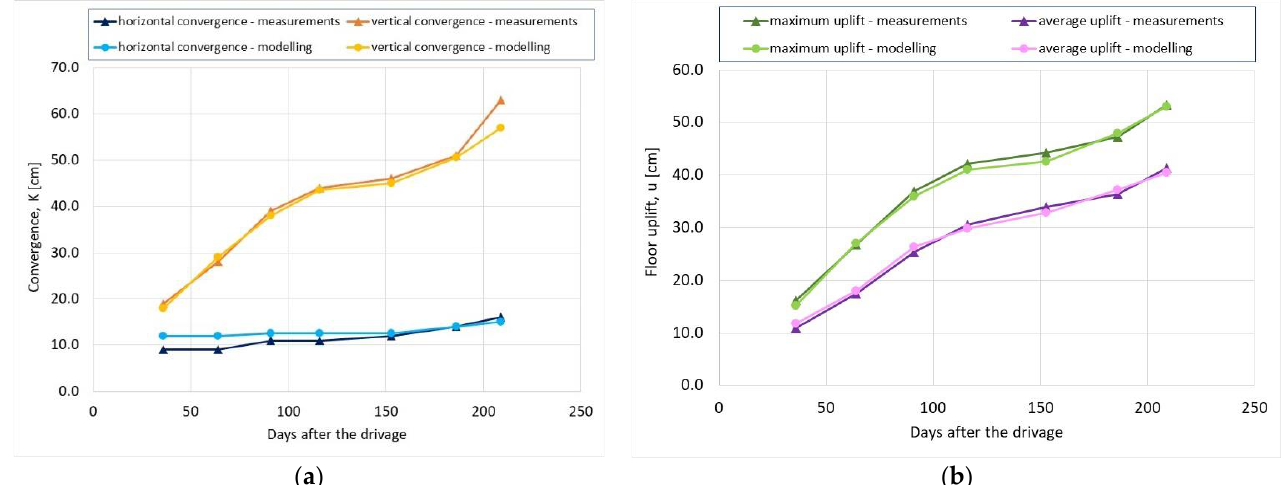
Figure 16. The consistency between numerical modeling and underground measurements of roadway F-33 deformation at chainage 405 m. ( a ) Convergence. ( b ) Floor uplift.